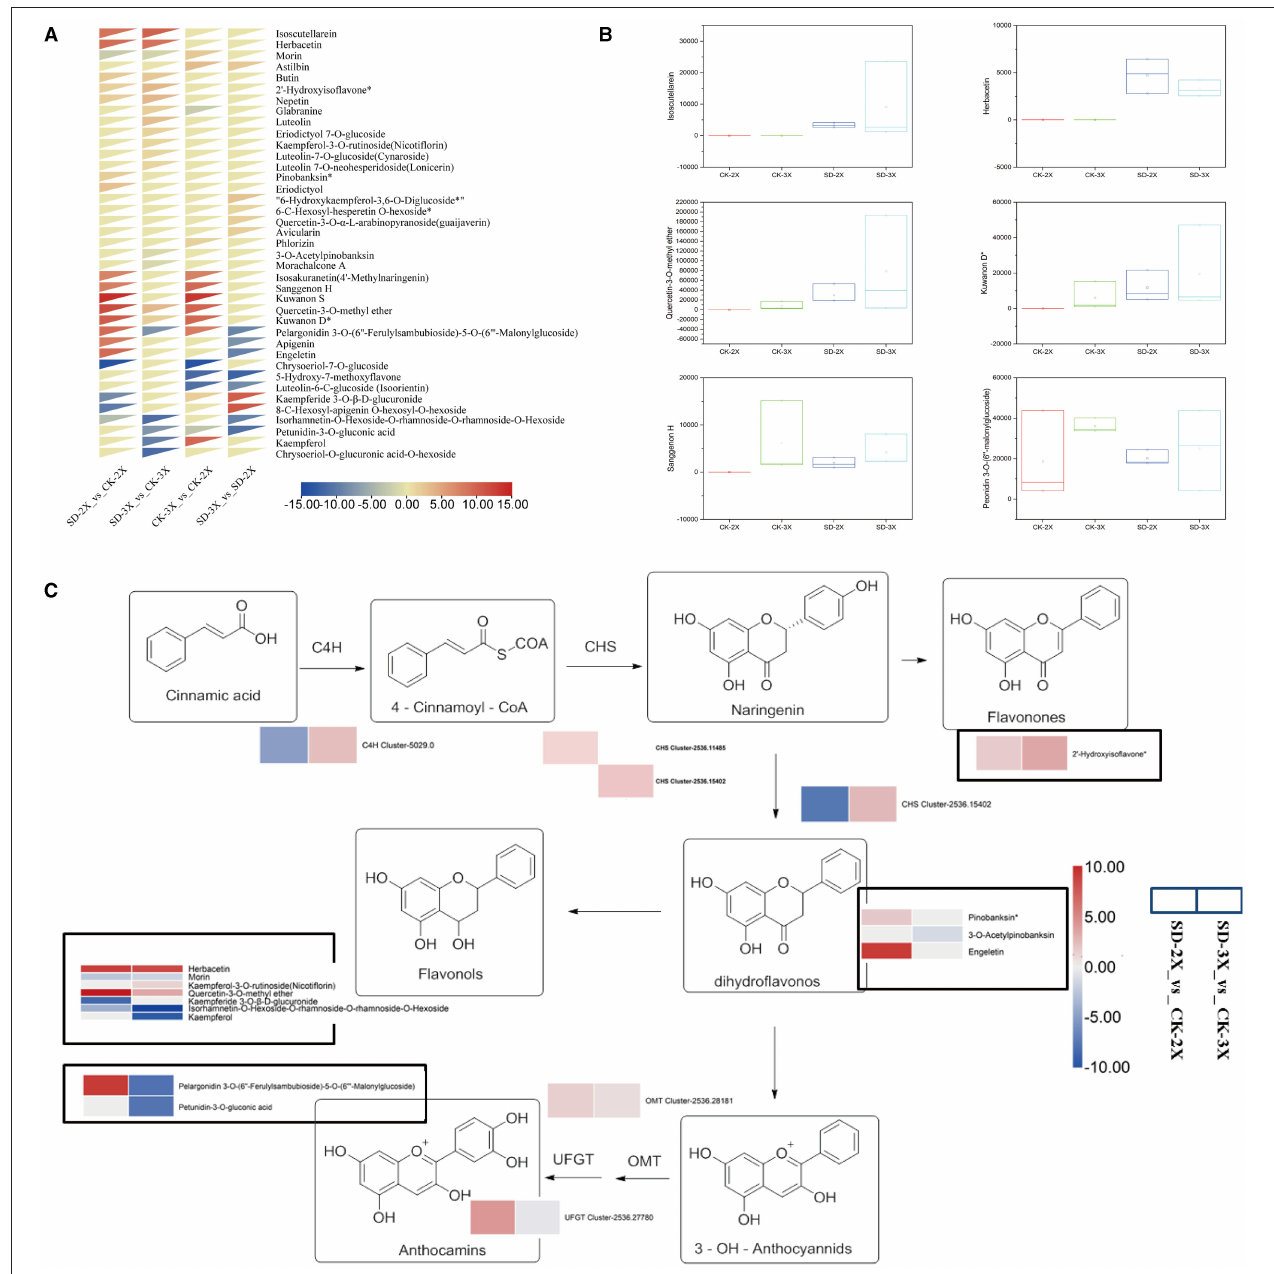
FIGURE 4 | Differentially accumulated metabolites identified from diploid (2X) and triploid (3X) involved in the flavonoid biosynthesis under drought stress and overview of the major metabolic and transcript changes response to drought stress. (A) Heatmap hierarchical clustering showing metabolite fold change in diploid (2X) and triploid (3X) in comparison with the control. The color scale for hierarchical clustering is labeled. The scale bar displays fold change values. (B) Box plot for the temporal variability of key flavonoid compound signal intensities in all samples. (C) Overview of the major metabolic and transcript changes response to drought stress in diploid (2X) and triploid (3X). Arrows show the metabolic stream. The genes and metabolites that are up-regulated and down-regulated are shown in red and blue, respectively. Circled in black is the metabolite data. The scale bar displays fold change values. Abbreviations: cinnamic acid-4-hydroxylase, C4H, chalcone synthase; CHS, UDP-glucose favonoid-3-O-glucosyltransferase; UFGT, O-methyltransferase; OMT. CK, control; SD, severe drought.